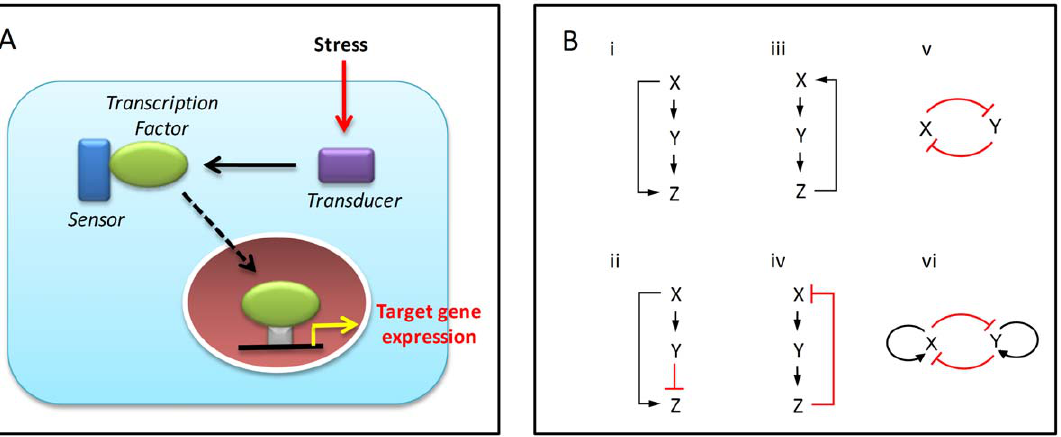
Figure 4. Stress response pathways and network motifs. (A) Typical structure of a stress response pathway (adapted from Simmons et al. [26]). The so-called eight canonical stress response pathways, conserved broadly across eukaryotes, have a common structure (common motifs) for sensing damage and mounting a transcriptional response to counteract the stress. (B) Common network motifs in intracellular response pathways. Three elements, (genes/proteins) X, Y, and Z, in a pathway can regulate each other to form: (i) a negative feedback loop; (ii) a positive feedback loop; (iii) a coherent feed-forward loop, where X activates Y, and both X and Y activate Z; and (iv) an incoherent feed-forward loop, where X activates both Y and Z, but Y suppresses Z. Two transcription factors X and Y can regulate each other through, for instance: (v) a double-negative feedback loop; or (vi) a double-negative feedback loop with positive autoregulation. Sharp arrows denote activation; flat arrows denote suppression.